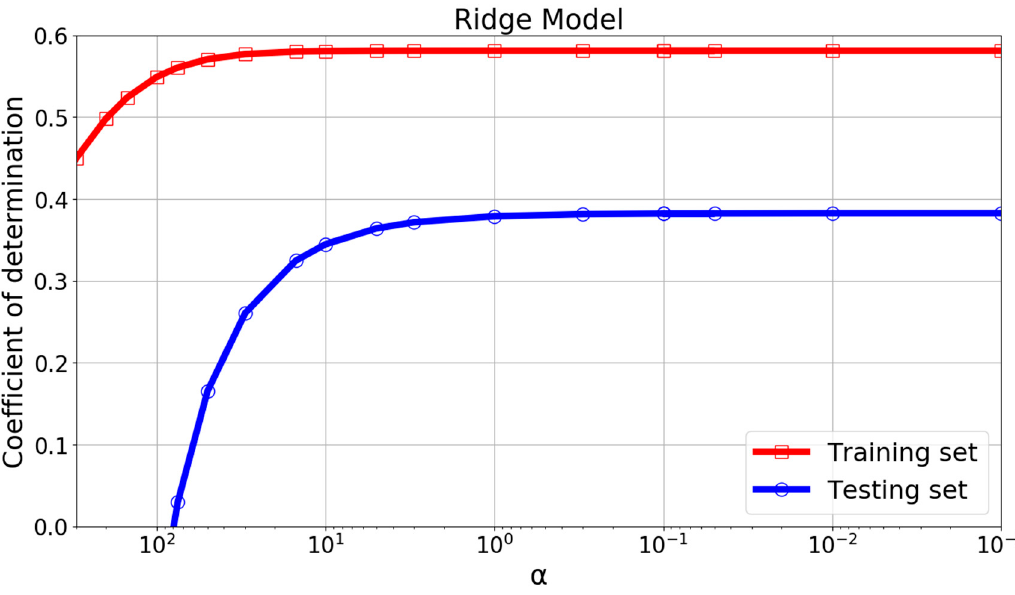
Figure 8. R 2 change curve of the Ridge model with parameter α.